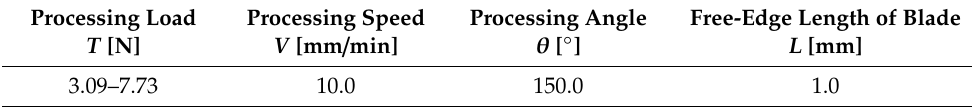
Table 3. Stick-slip (SS) processing conditions.